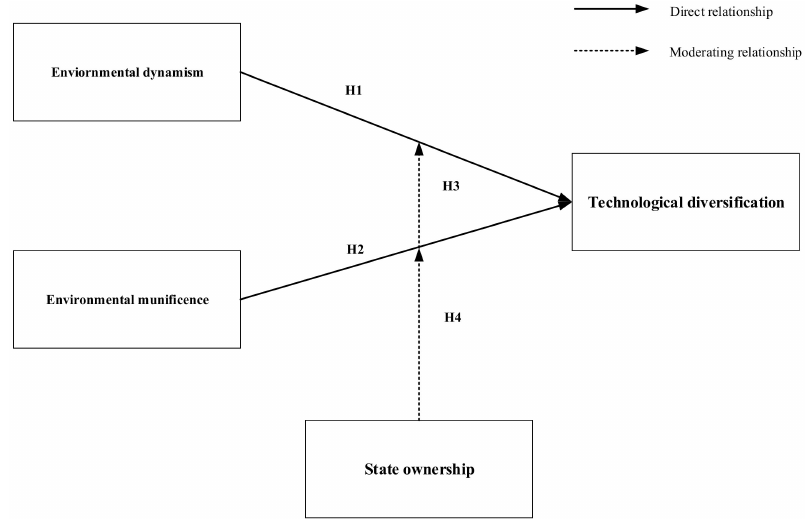
Figure 1. Conceptual